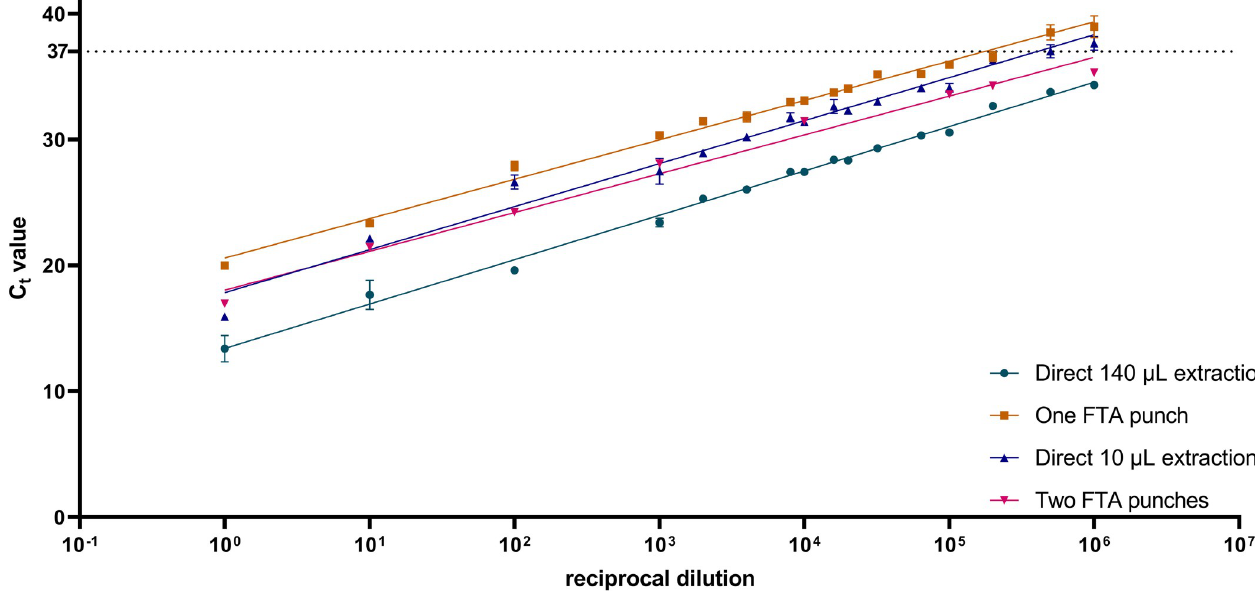
Fig 1. YFV RNA extraction from FTA punches lowers the sensitivity of YFV qRT-PCR assays based on volume, not technique. RNA from the vaccine strain of YFV, 17D-204, was extracted using the manufacturers protocol from 140 μ L of YFV diluted in PBS, from a single FTA punch, from 10 μ L of YFV diluted in PBS, and from two FTA punches. The dotted line at C t value 37 indicates the cut off for YFV RNA positivity and is based on the cut-off used in the molecular diagnosis of YFV in the field. Dilutions to make the standard curve were performed in PBS. Points represent the average of two experiments and were fit using a linear